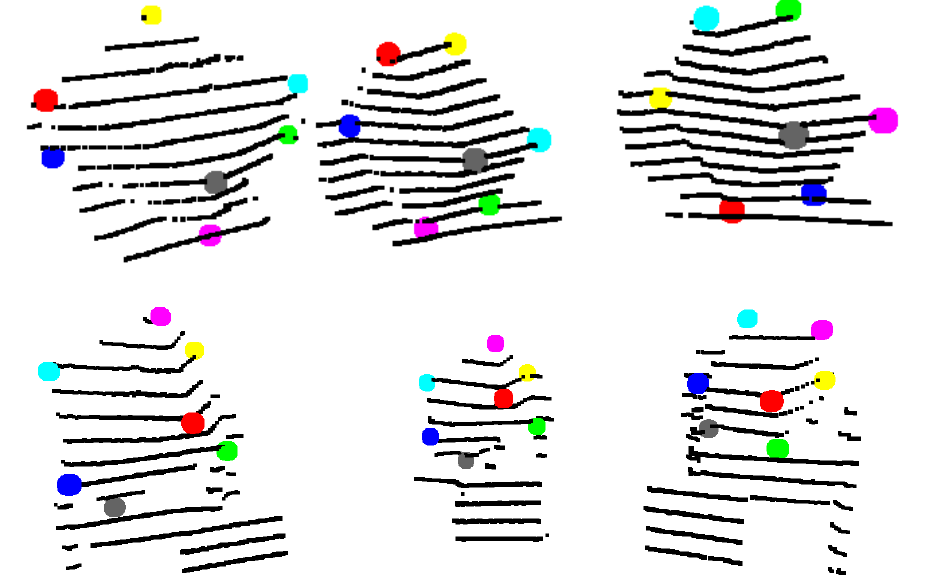
Figure 3. Examples of box corners found in different point clouds. The colored points indicate the calculated box corners, after the